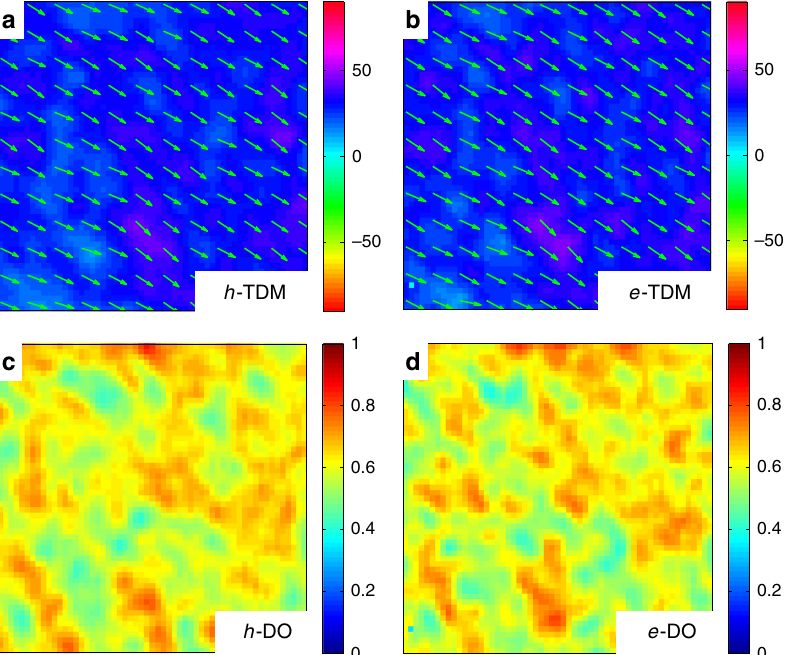
Fig. 4 CMM maps of the active channel probed at 1.18 eV, within the photoinduced charge absorption region. (15 μ m × 15 μ m) Source and drain electrodes are located at the left and right side of the maps. a , b Charge transition dipole moment (TDM charge ) maps acquired under h-acc and e-acc , showing the angular orientation of the anisotropic component of the charge modulation signal. Green arrows indicate that the TDM holes and TDM electrons mostly distribute along the polymer chains alignment direction. c , d Maps acquired under h-acc and e-acc , showing the local degree of order (DO), quantifying the weight of the anisotropic component of the charge modulation signal with respect to the isotropic component. Probing conditions: for e-acc , V g = 30 V, V = 40 ± 20 V; for h-acc , V = − 30 V; V = 40 ± 20 V pp g pp